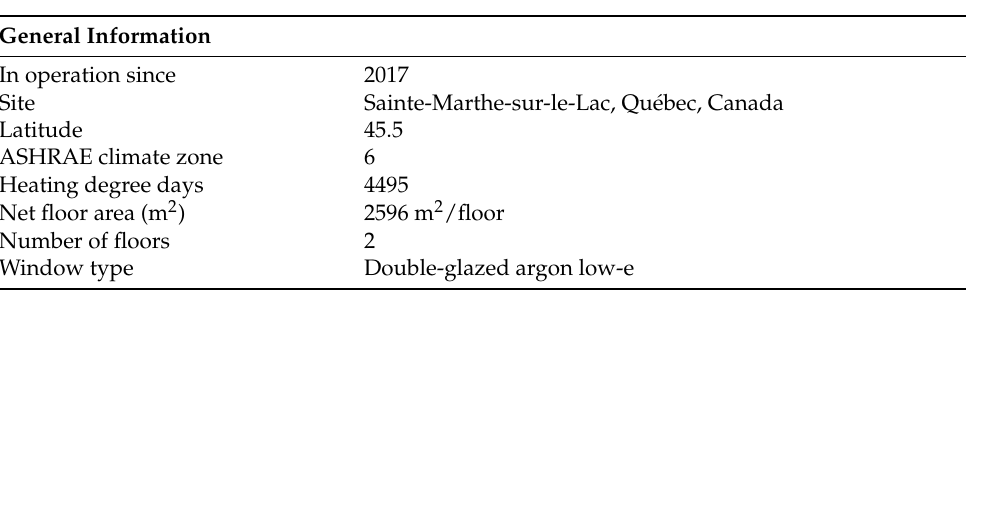
Table 2. Key features of the school building.